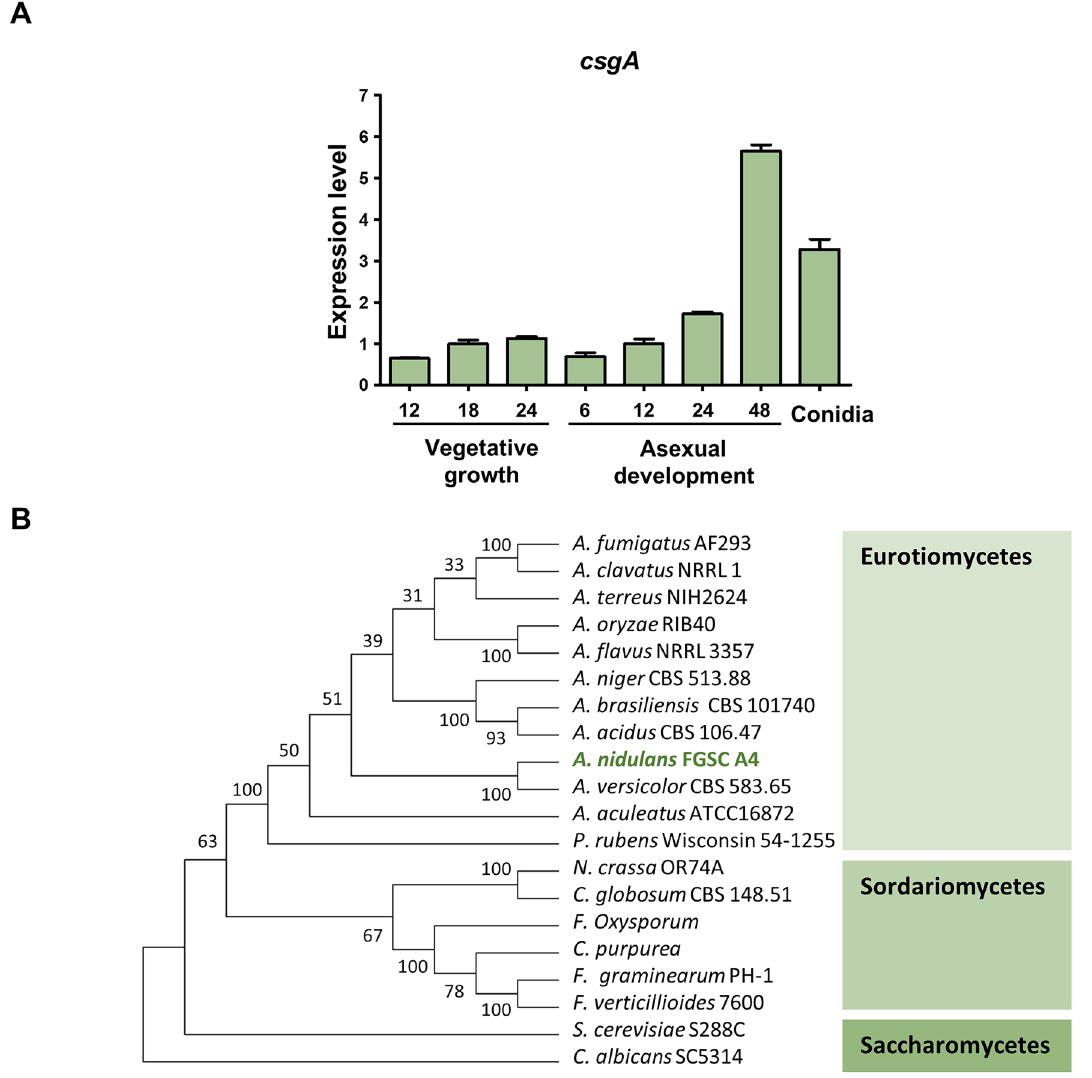
Figure 1. Summary of csgA evolution and expression. ( A ) Expression levels of csgA during the life cycle of A. nidulans measured by qRT-PCR. ( B ) Phylogenetic analysis of CsgA homolog proteins identified in ascomycota species, including A. fumigatus (XP_755373.1), A. clavatus (XP_001275339.1), A. terreus (XP_001213655.1), A. oryzae (XP_001826209.3), A. flavus (XP_041150305.1), A. niger (XP_001399754.2), A. brasiliensis (OJJ76189.1), A. acidus (OJZ92039.1), A. nidulans (XP_663559.1), A. versicolor (XP_040666950.1), A. aculeatus (XP_020060042.1), Penicillium rubens Wisconsin (XP_002565962.1), Neurospora crassa (KHE82752.1), Chaetomium globosum (XP_001223925.1), Fusarium oxysporum (EXA29503.1), Claviceps purpurea (KAG6216579.1), F. graminearum (XP_011323014.1), F. verticillioides (XP_018761247.1), Saccharomyces cerevisiae (NP_013199.1), and Candida albicans